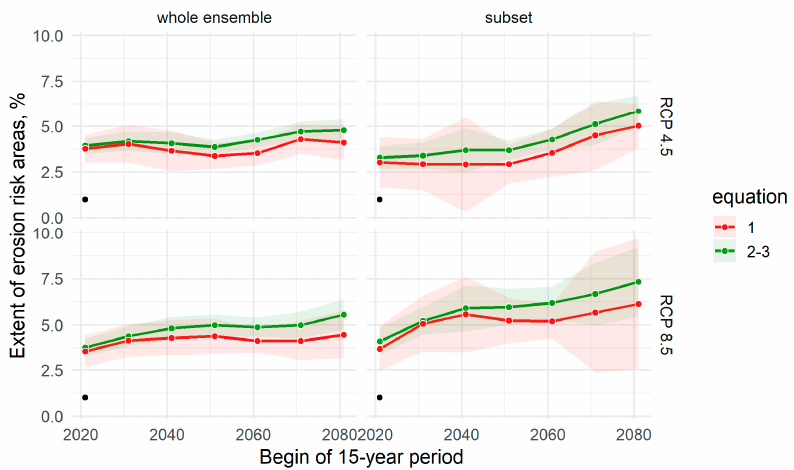
Figure 10. Future share of arable land with erosion risk, ensemble mean and confidence interval (p = 95%) of bias-corrected climate models for overlapping 15-year periods. Current value of 3.2% derived from the revised state erosion map in black.